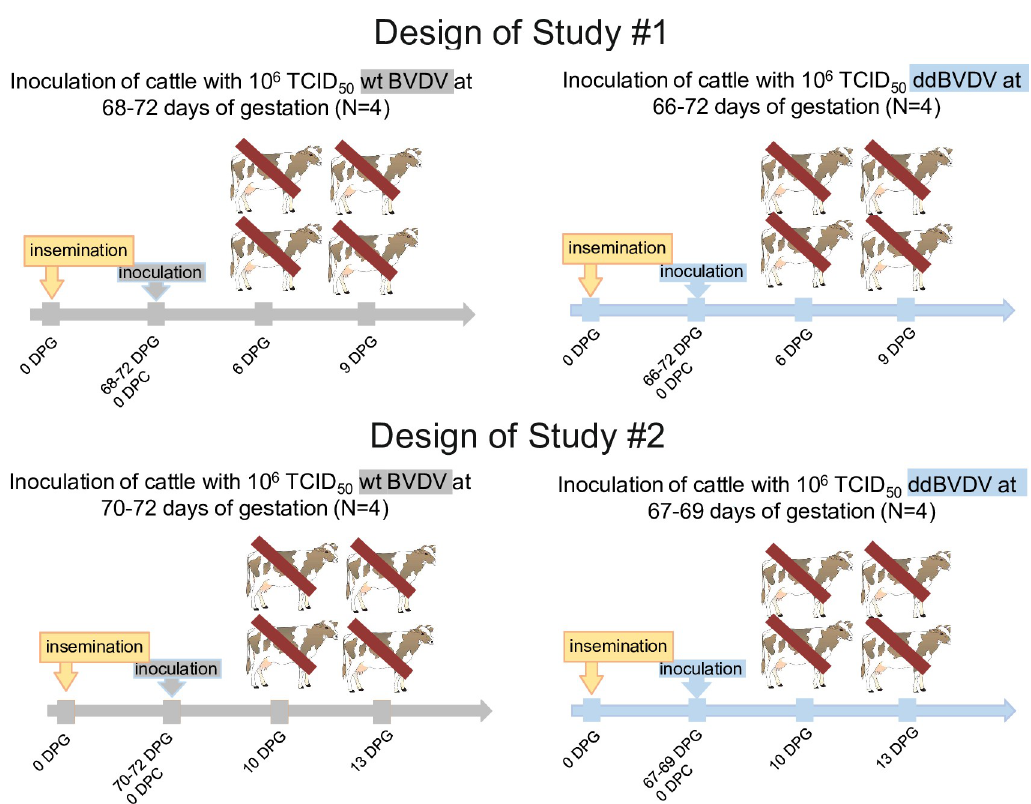
Fig 1. Study design configuration for wt BVDV and ddBVDV pregnant bovine trial. DPG: days post gestation: DPC: days post challenge infection.